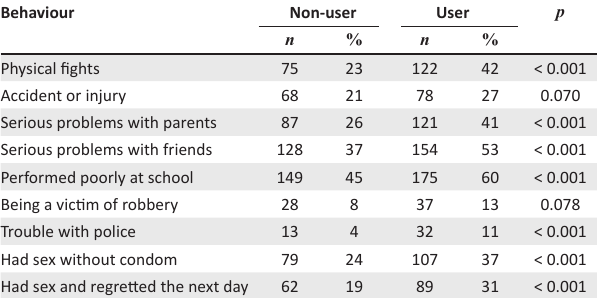
TABLE 3: Associations between behaviours and substance use.